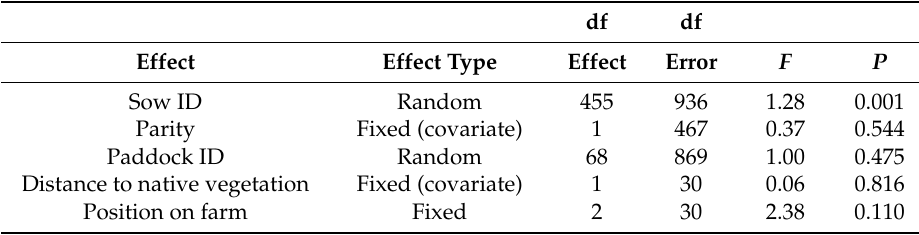
Table 1. Mixed model ANOVA results indicate sow ID has a significant effect on the weaning rate (proportion of piglets weaned to born